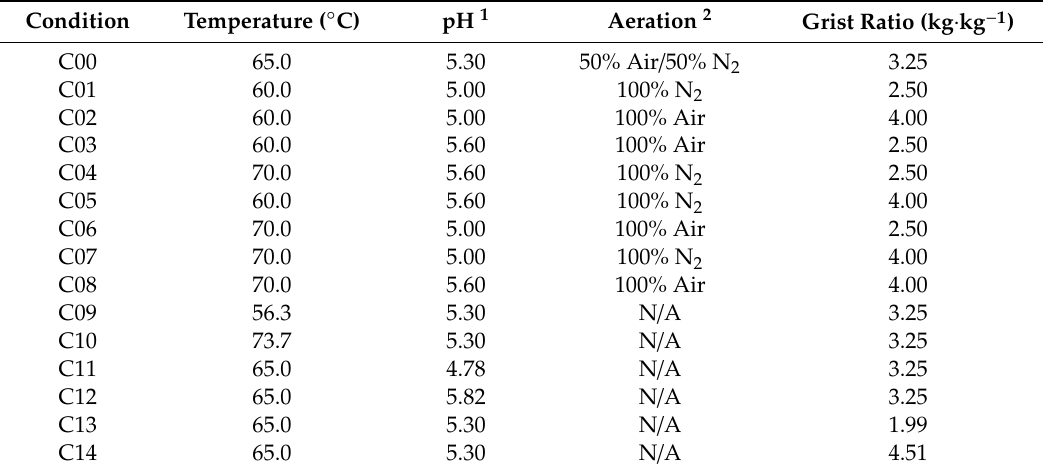
Table 1. Fifteen experimental mash